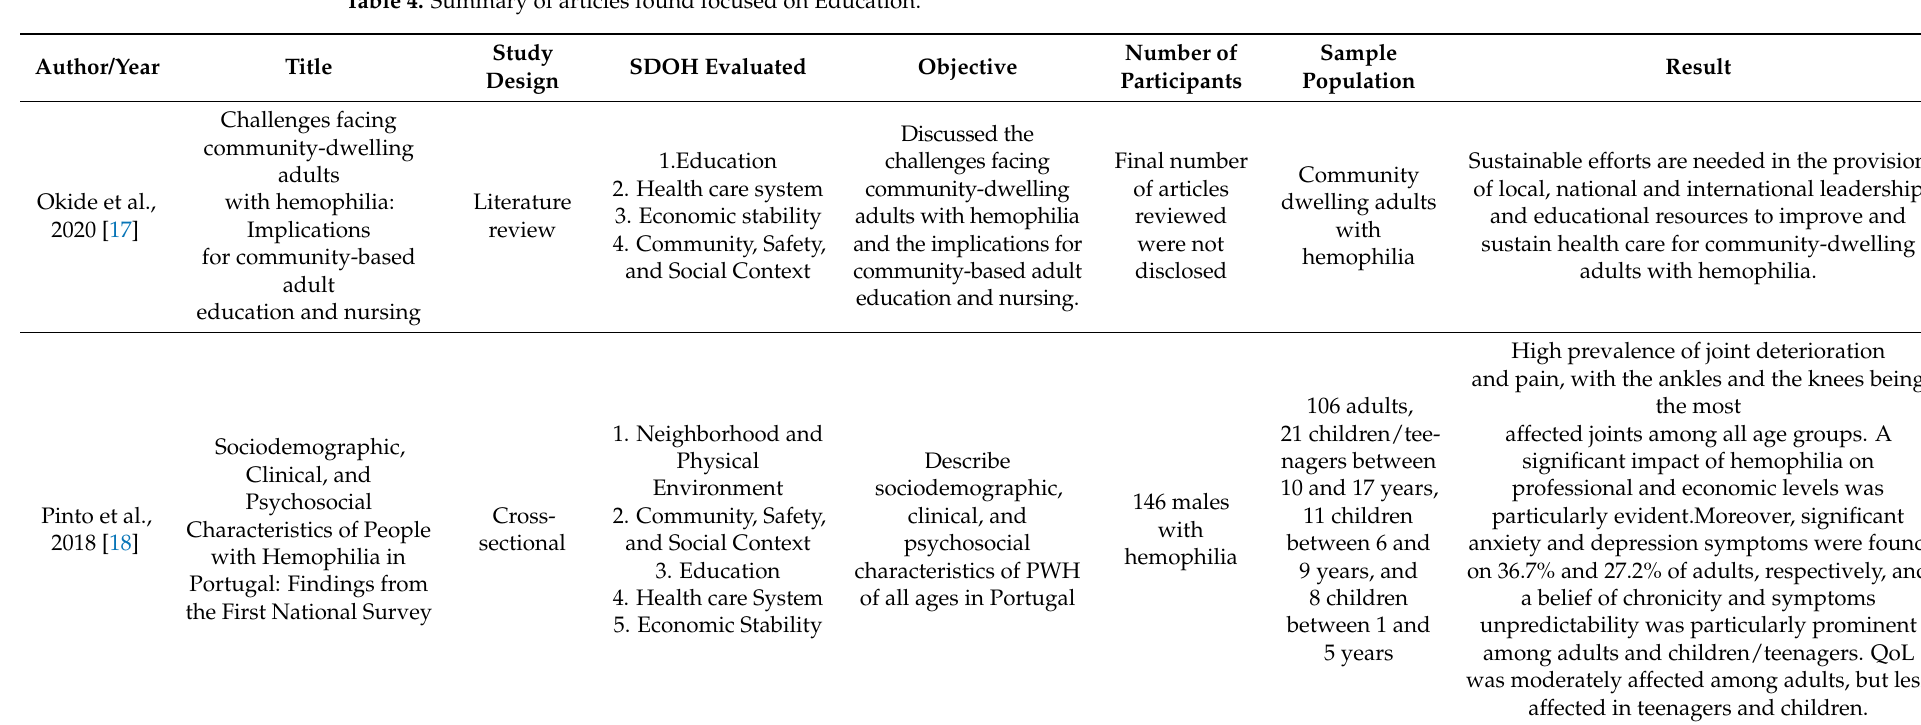
Table 4. Summary of articles found focused on